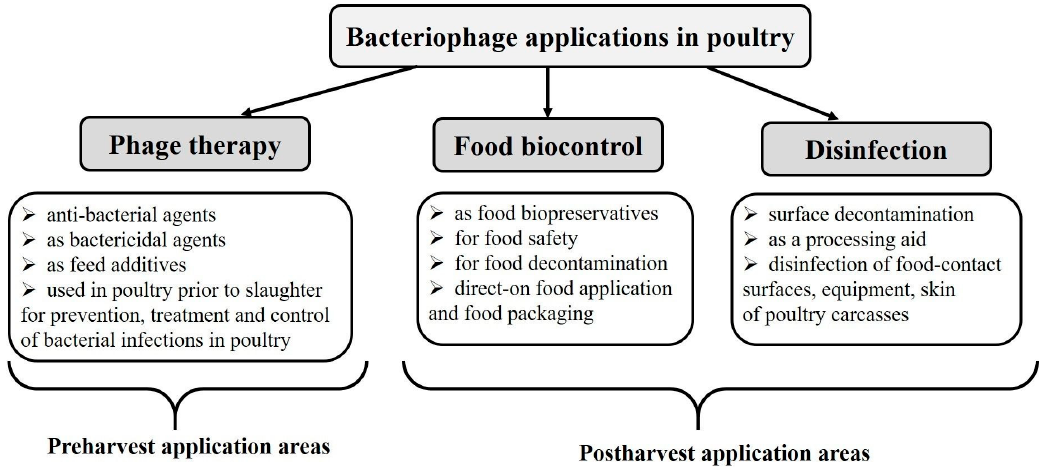
Figure 2. Examples of phage application in the poultry industry.